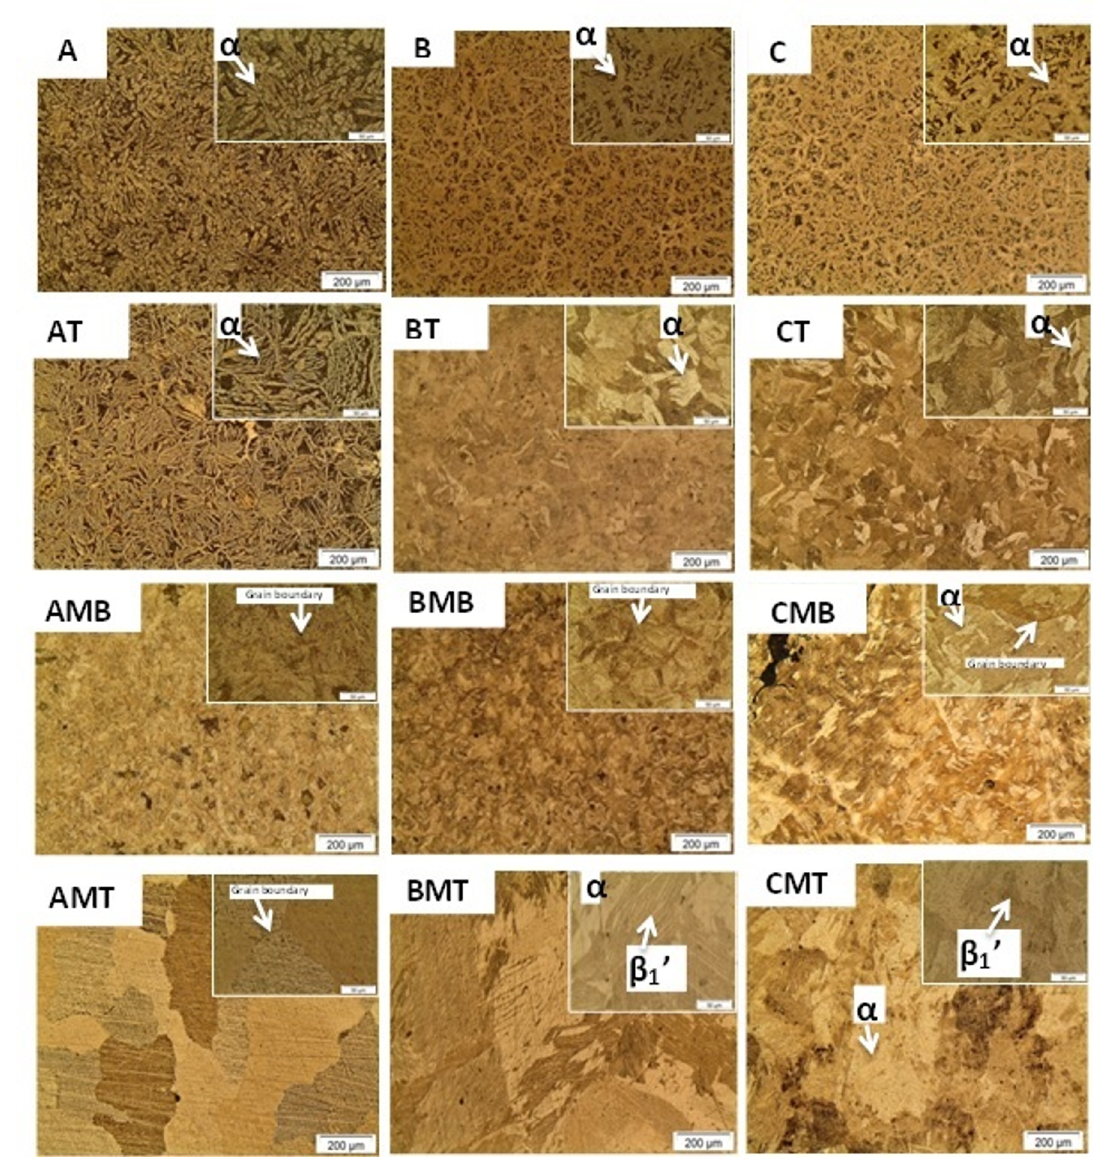
Figure 7. Microstructures of all the studied non-modified and modified bronze alloys (Cu-Al-Ni